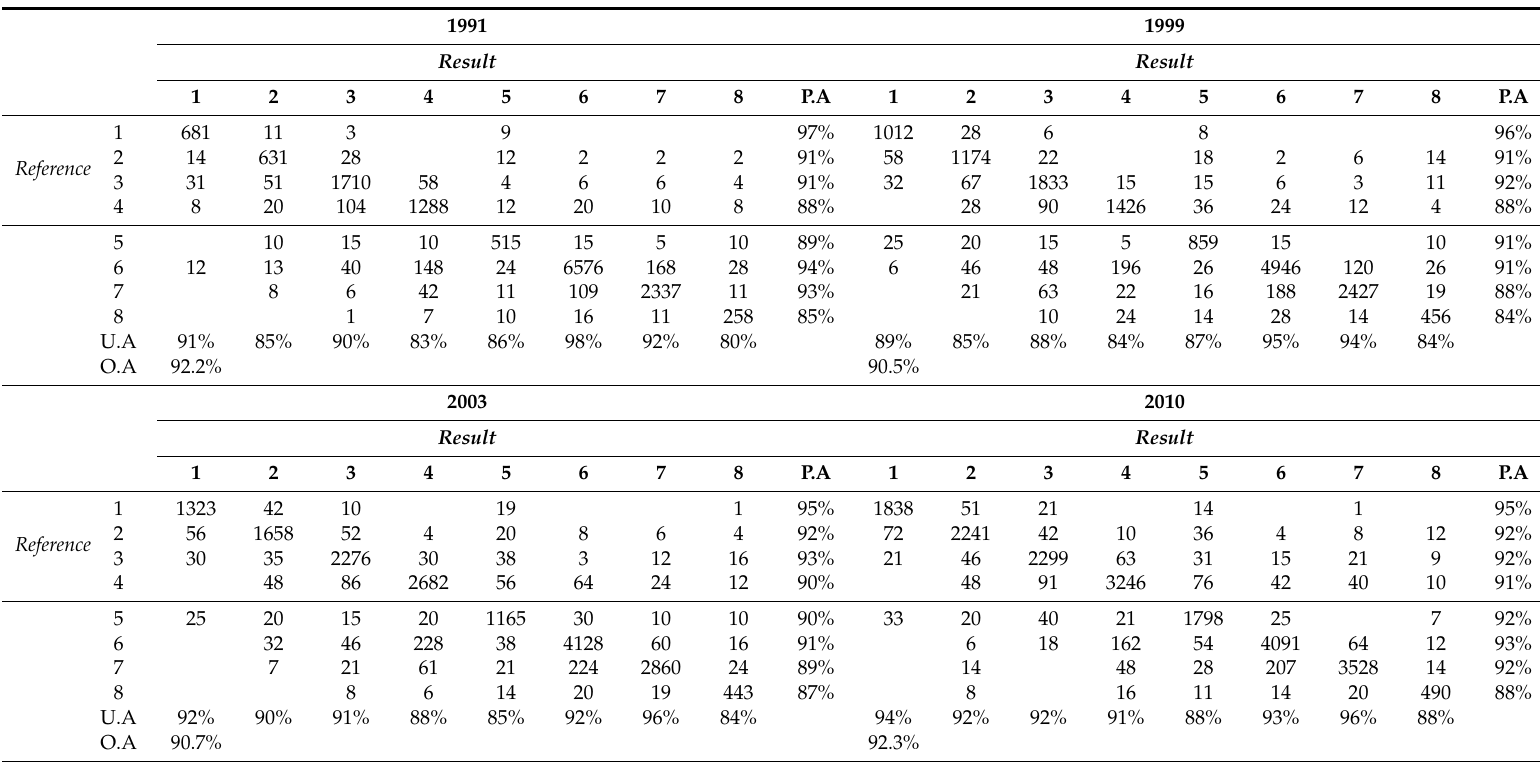
Table 3. Error matrix—resulting map per year against reference samples. U.A: User’s Accuracy; P.A: Producer’s Accuracy; O.A: Overall Accuracy. 1: Continuous